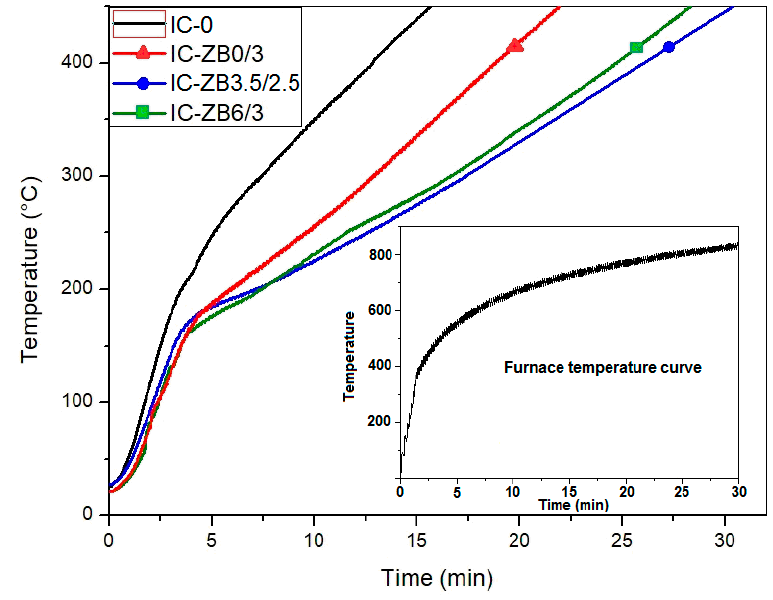
Figure 6. Thermal insulation curves for the selected intumescent coatings with various zinc borates.